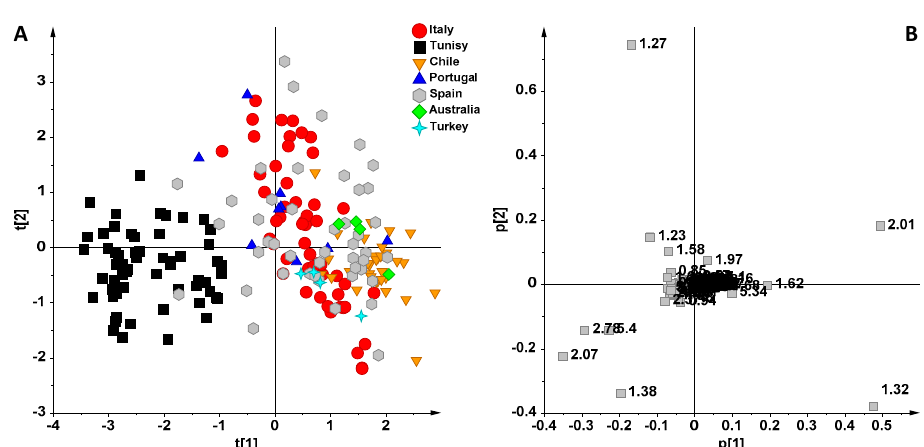
Figure 1. ( A ) Principal Component Analysis (PCA) (t[1]/t[2] scoreplot for the whole Nuclear Magnetic Resonance (NMR) dataset of extravirgin olive oils (EVOOs) (six components give R2X(cum) = 0.925 and Q2(cum) = 0.822). ( B ) Loading plot for the model; the variables indicated ppm in the 1 H NMR spectra.